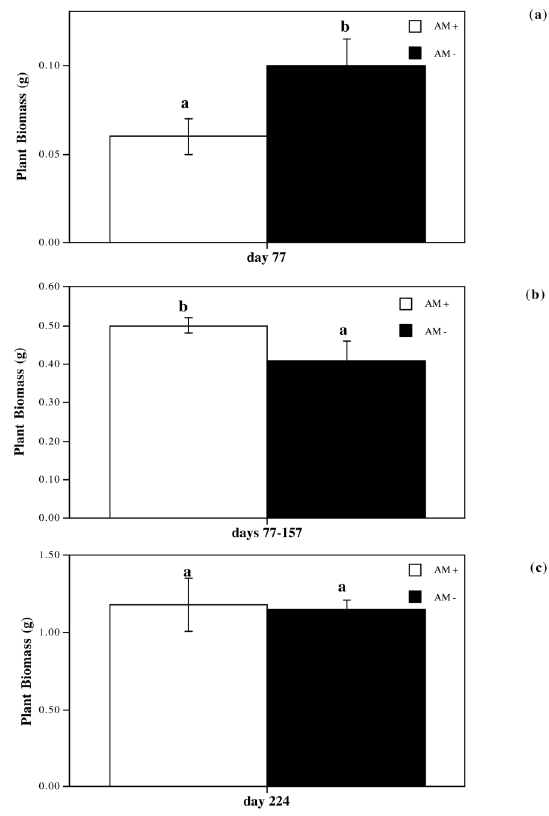
Fig. 3 . Relative growth rate (mg g –1 day –1 ) of Agathosma betulina for (a) the growth period 0–77 days, (b) the growth period 77–157 days and for (c) the growth period 157–224 days. Differences between arbuscular mycorrhizal inoculated (+AM) and non-AM (–AM) plants were determined by t-test for independent samples by groups. Statistically significant differences (p £ 0.05) between AM inoculated and non-AM plants for each growth period are in- dicated by different letters. Error bars represent mean ± SE (n =